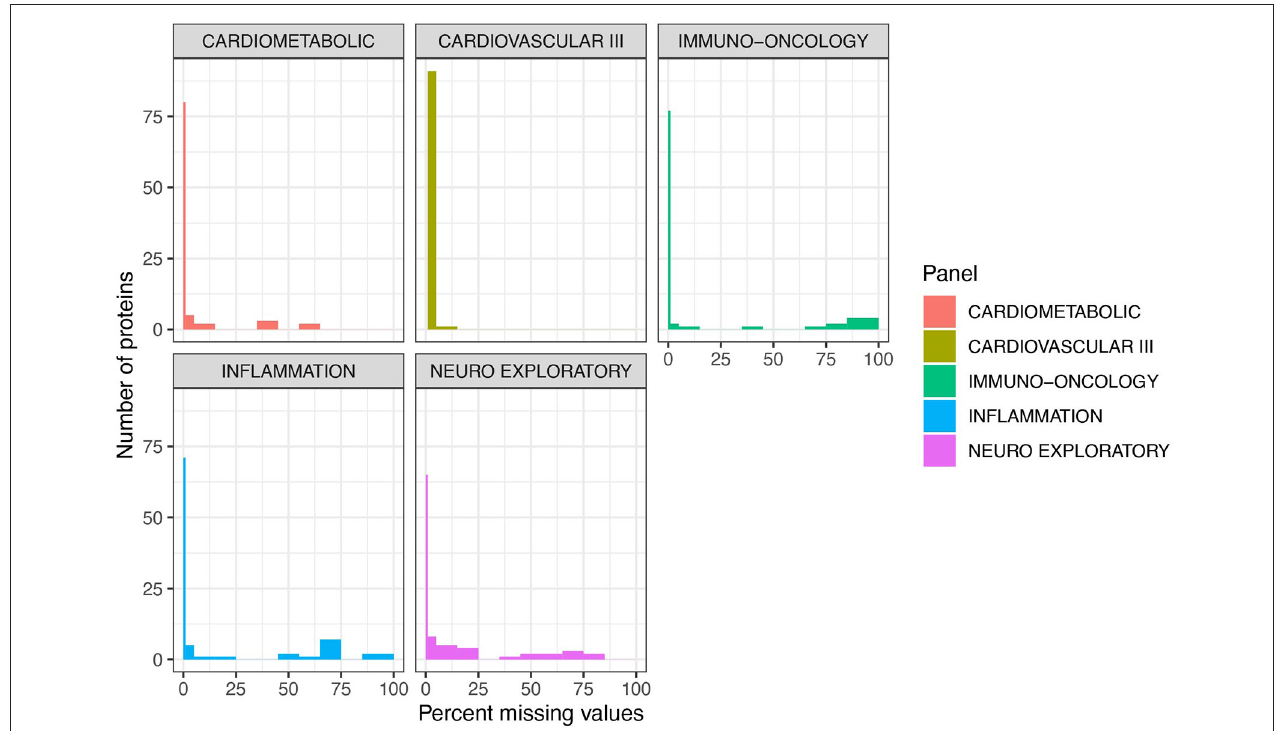
FIGURE 2 | Cardiovascular III and Cardiometabolic panels demonstrate the lowest percentage of missing values per number of proteins. Five of Olink’s multi-analyte panels [Cardiometabolic (v.3602), Cardiovascular III (v.6112), Immuno-oncology (v.3103), Inflammation (v.3021), and Neuro Exploratory (v.3901)] containing AD-relevant biomarkers were used to quantify 414 unique proteins. Across all five panels, 189 proteins had zero missing values. These proteins are shown with the thin line at 0 on these plots. Note that 1 sample failed on the Cardiovascular III panel, and thus there are zero proteins with zero missing values. Cardiometabolic and Cardiovascular III panels demonstrated the highest performance overall, with a very low number of proteins with a majority of missing values. Across all 5 panels, 45 proteins had over 20% missing values and were excluded from further analysis.